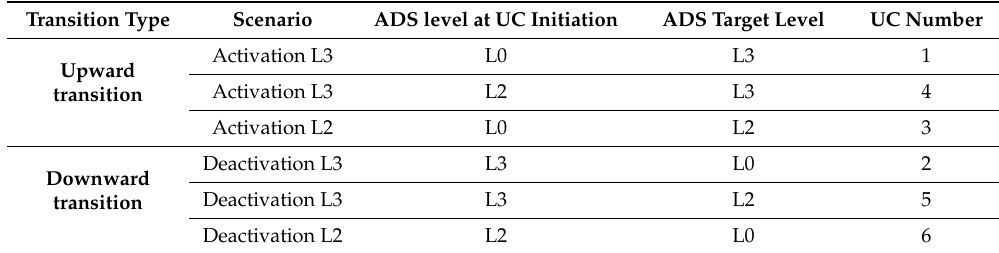
Table 2. Overview of use cases for one experimental